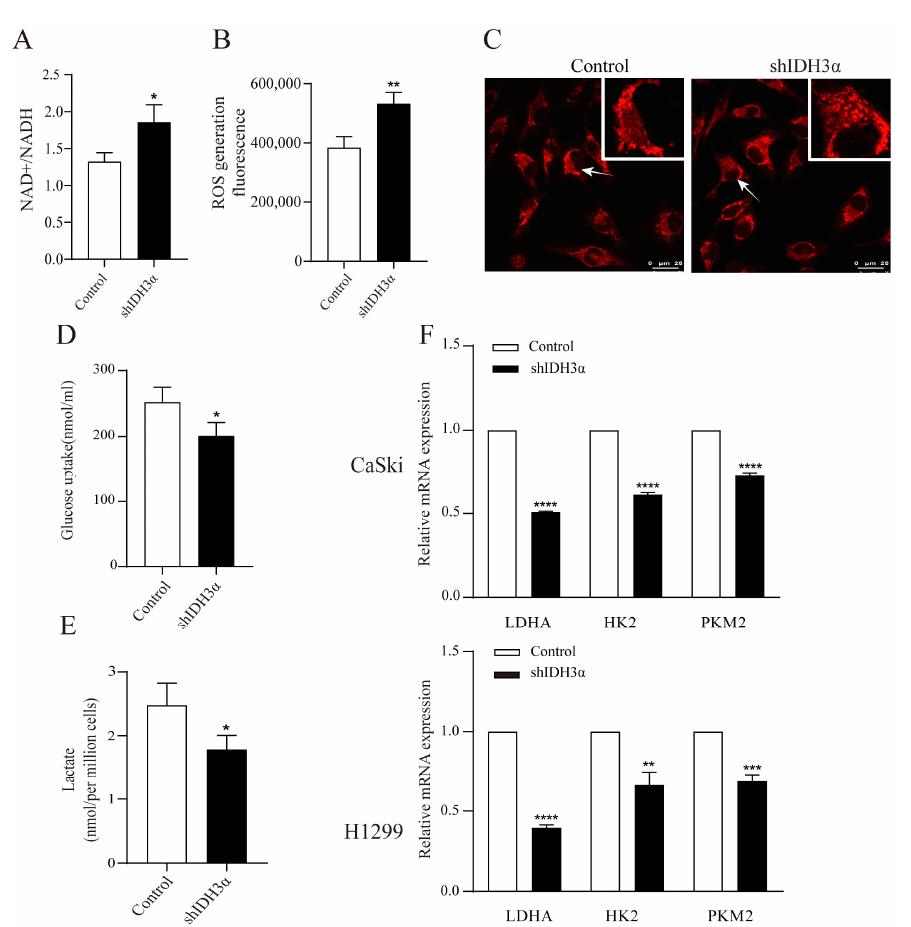
Figure 4. The effects of IDH3 α knockdown on redox status and glycolysis ability. ( A ) NADH oxidase activity was assessed in H1299 cells. ( B ) ROS detection was assessed by using the Cellular Reactive Oxygen Species Detection Assay Kit (Red Fluorescence) in H1299 cells. ( C ) Confocal microscopy visualization of mitochondrial morphology after mitochondrial staining with the mitochondrial tracker red CMXRos in HeLa cells. Arrows represent mitochondria. ( D ) Glucose uptake in H1299 ‐ shIDH3 α and control cells. ( E ) Lactate concentration in H1299 ‐ shIDH3 α and control cells. ( F ) Glycolysis ‐ related markers were detected by quantitative PCR. Data are shown as mean ± SD. * p < 0.05, ** p < 0.01, *** p < 0.001 and **** p < 0.0001.